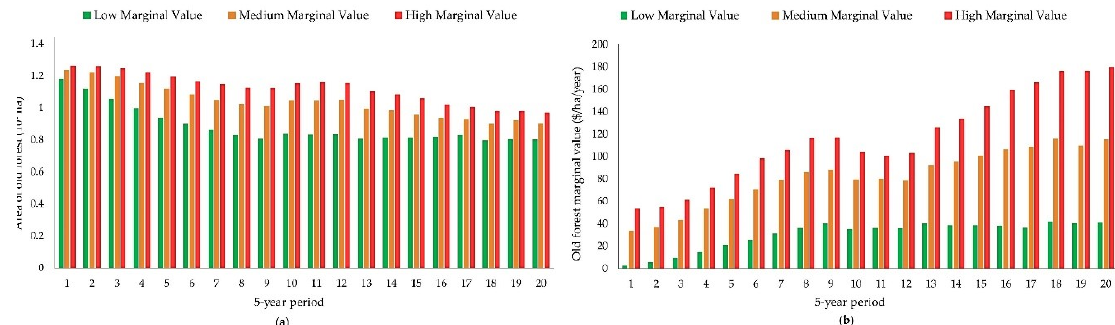
Figure 9. Old forest flow (million hectares) ( a ) and their marginal value estimates for old forest under the three marginal value functions ($/ha/year) ( b